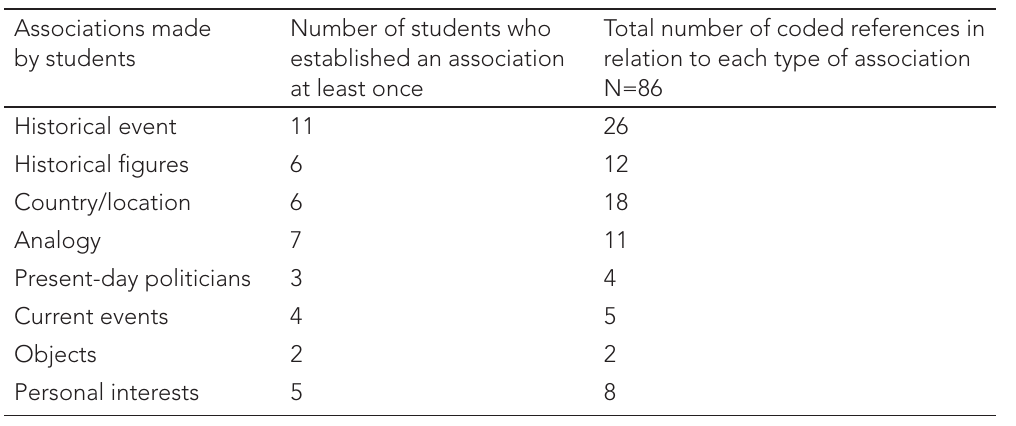
Table 1: Making associations Associations